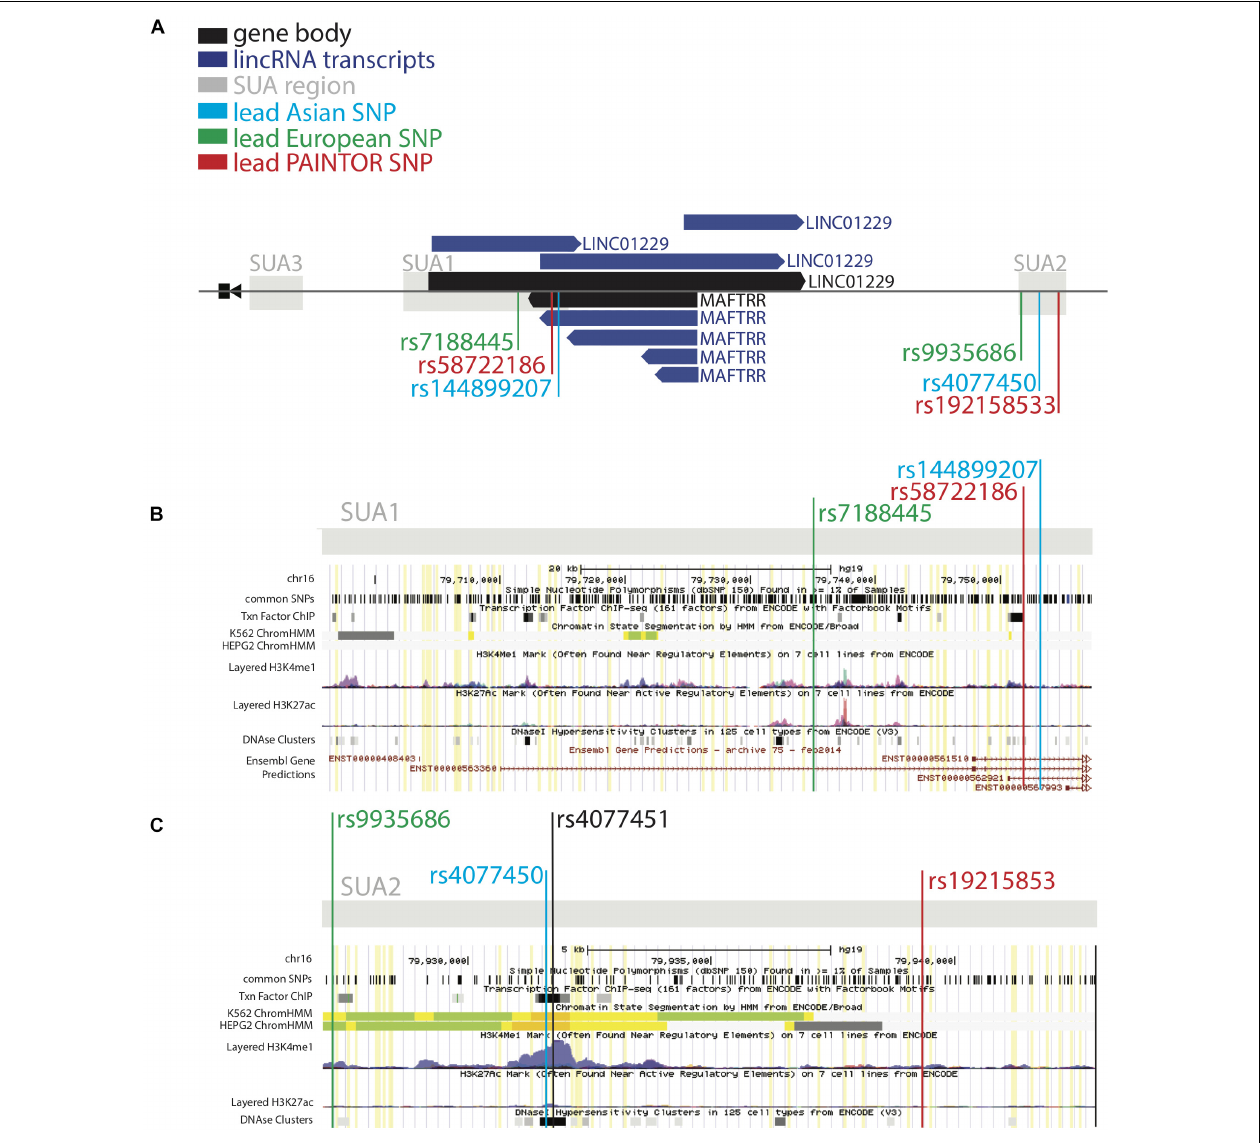
FIGURE 2 | SUA2 has hallmarks of enhancer function. (A) The MAF upstream region marked by SUA variants in Köttgen et al. (2013) and Kanai et al. (2018). LincRNA gene bodies (black) and transcripts (dark blue) are depicted. (B,C) ENCODE screenshots of the SUA1 and SUA2 regions. The presence of enhancer elements; DNaseI hypersensitivity regions (DHS) (Thurman et al., 2012), H3K27ac and H3K4me1 chromatin modifications (Heintzman et al., 2009), transcription factor binding sites (Wang et al., 2012) and predicted ChromHMM enhancers (Ernst and Kellis, 2017) are shown. Yellow lines indicate Köttgen SUA